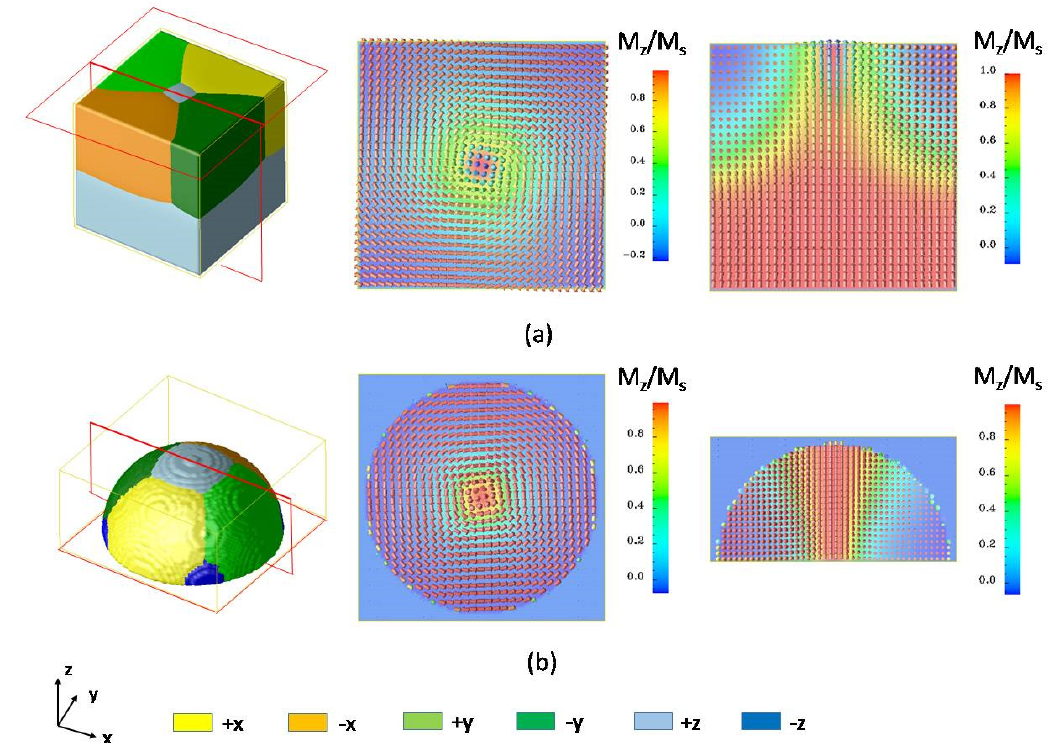
Figure 3. The simulated ferromagnetic domain structure and magnetization distributions of composite FePt/Fe with ( a ) bilayer structure ( b ) core–shell structure.